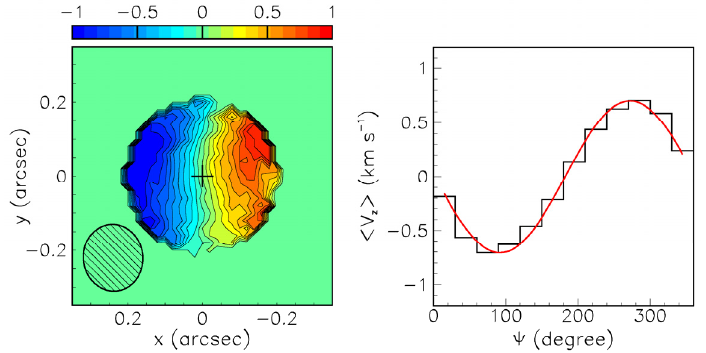
Figure 3 : SO 2 emission of EP Aqr: sky map of the mean Doppler velocity (km s − 1 , R < 0.2 arcsec) (left) and dependence of the Doppler velocity on position angle ψ for 0.05 < R < 0.15 arcsec (right). The absence of high velocities in SO 2 emission, if not the result of insufficient sensitivity, implies that the high velocity wings do not occur very close to the star. It also disfavours an interpretation in terms of a spherical shell ejected by star pulsation at short distances from the star, as described in Winters et al. [1] and McDonald & Zijlstra [19].